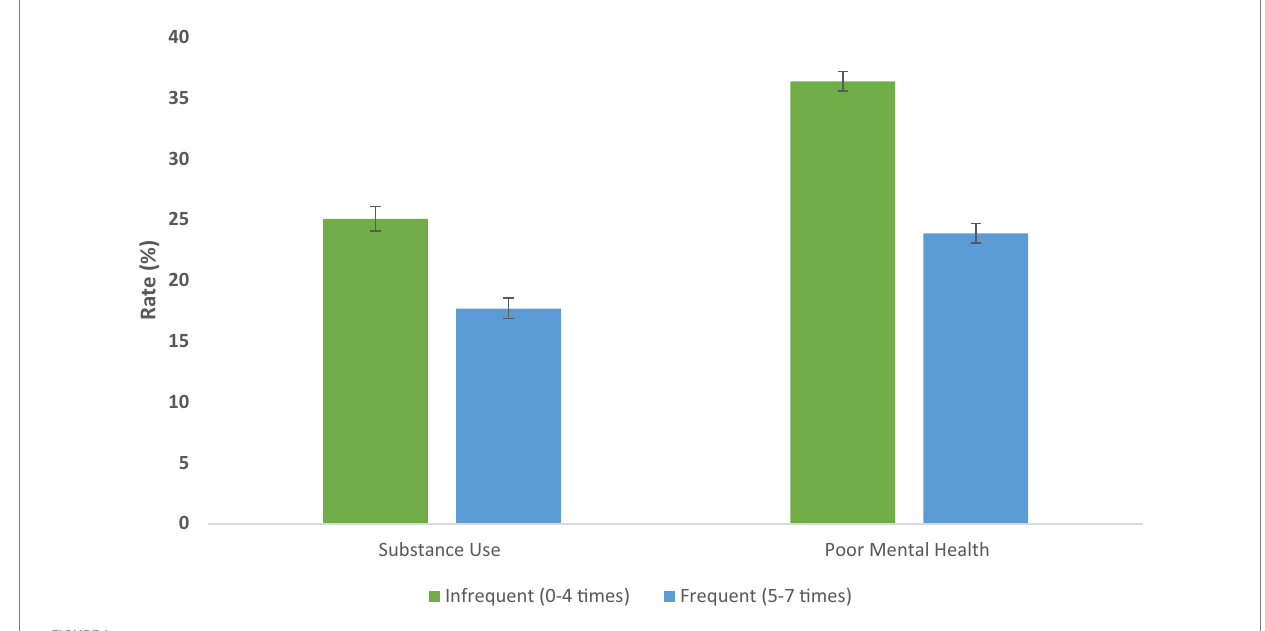
FIGURE 1 Percentage of substance use and poor mental health among adolescents with infrequent and frequent family